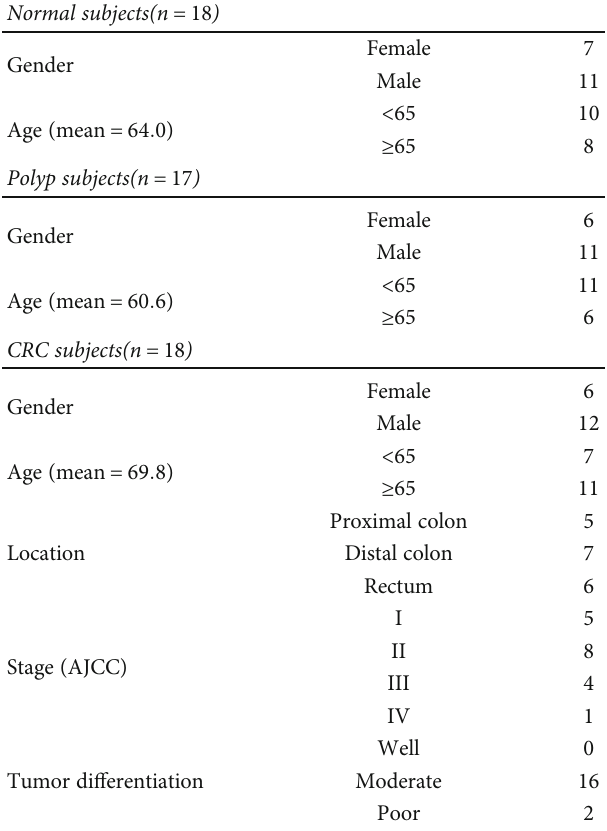
3Stem Cells Table 1: Clinical characteristics of normal, polyp, and CRC patients.